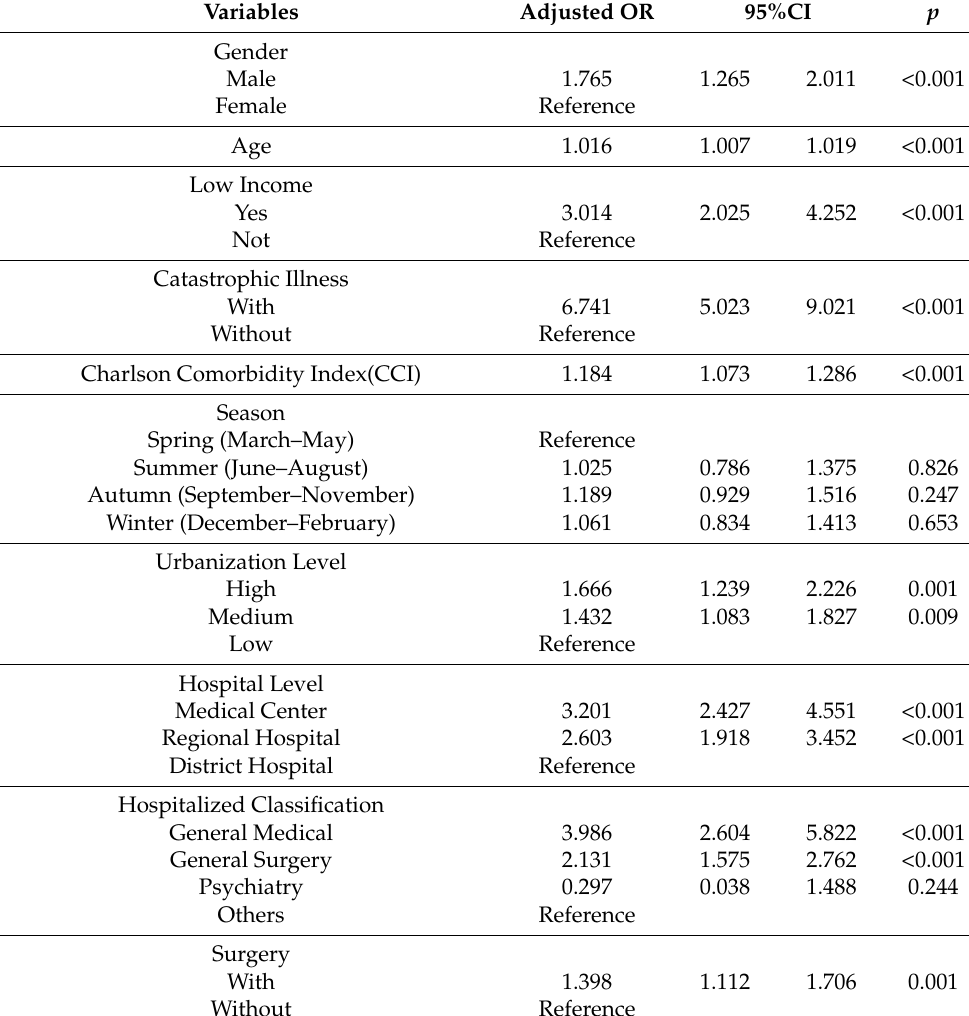
Table 3. Relevant factors of inpatient mortality due to homicide and assault (n = 95,878).